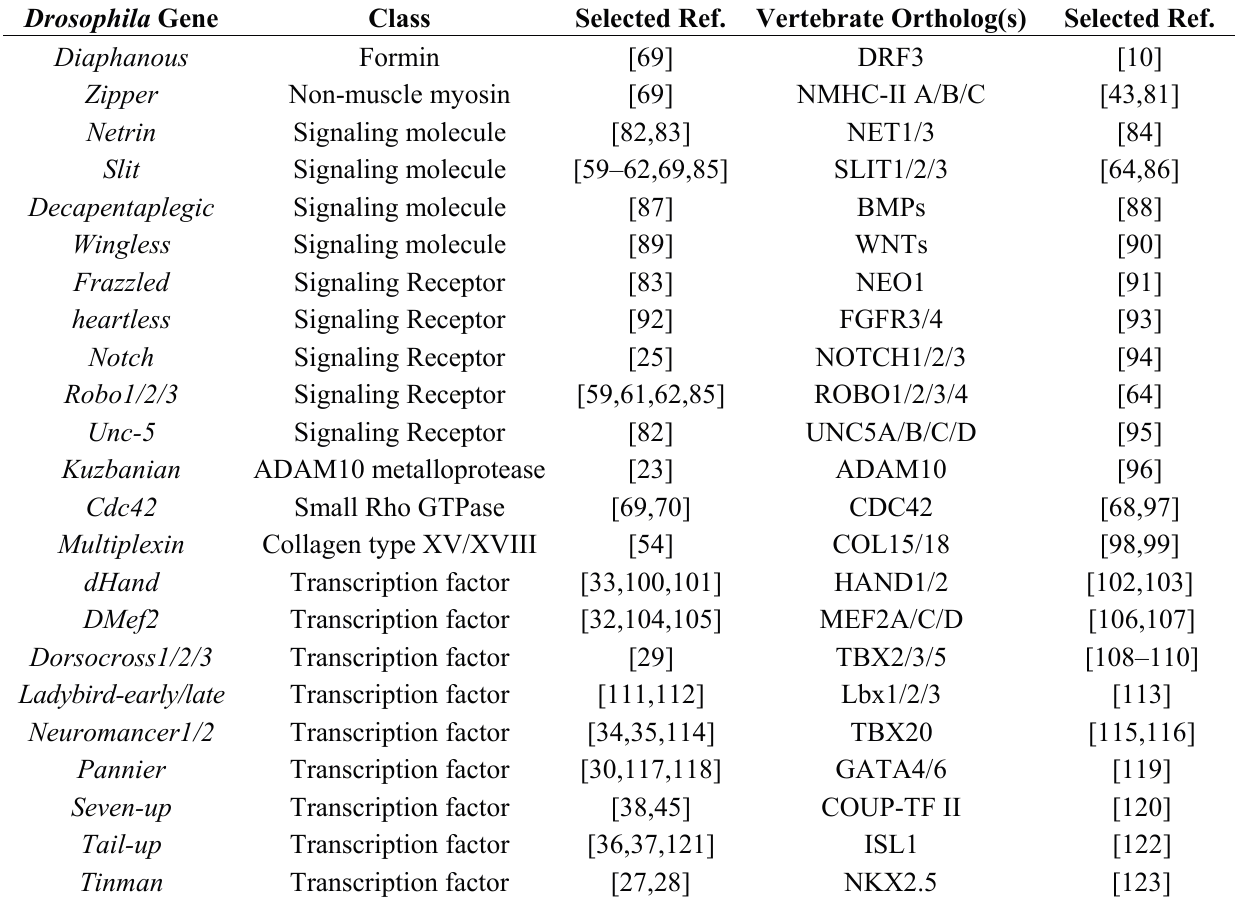
Table 1. List of selected Drosophila genes regulating heart development. Drosophila